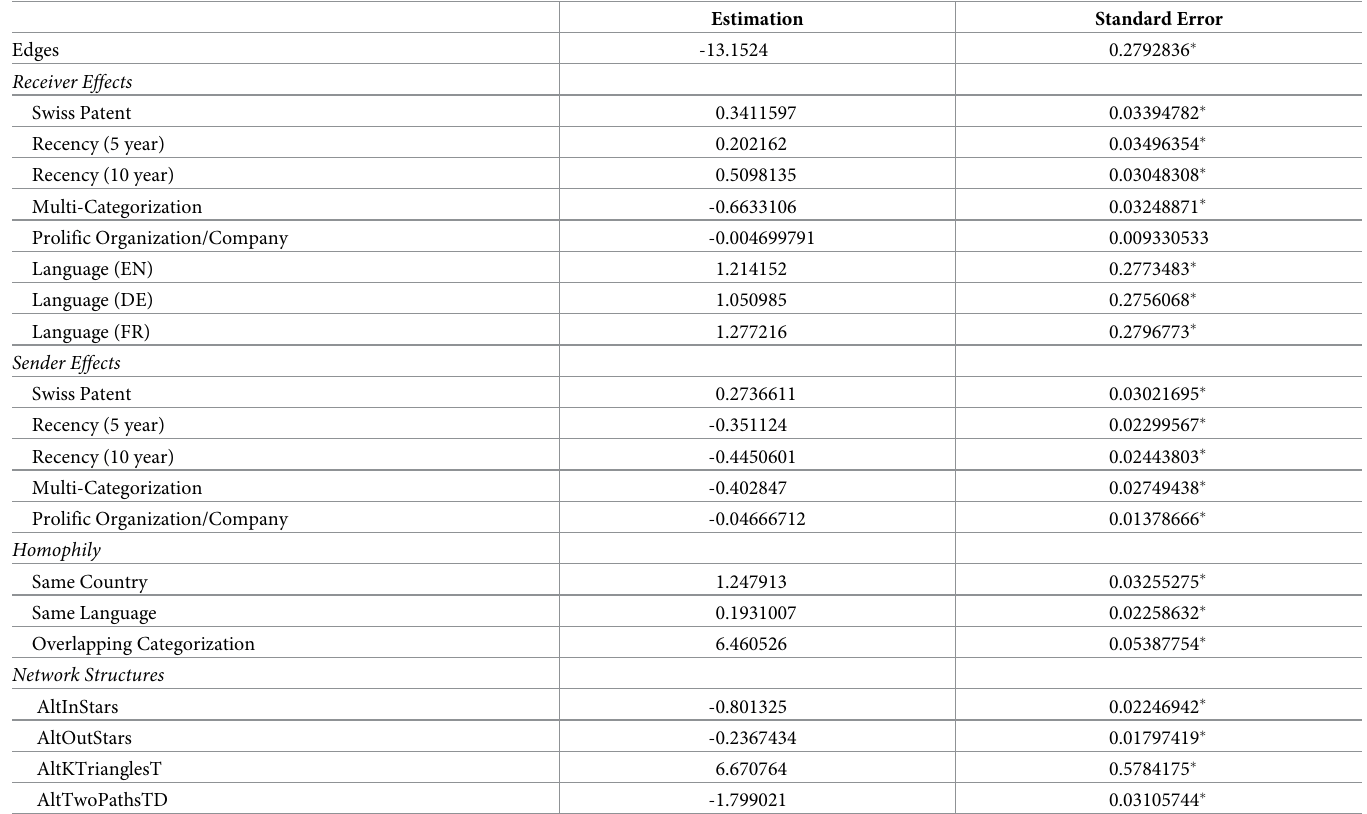
Table 8. ERGM results for predicting the sector B citation